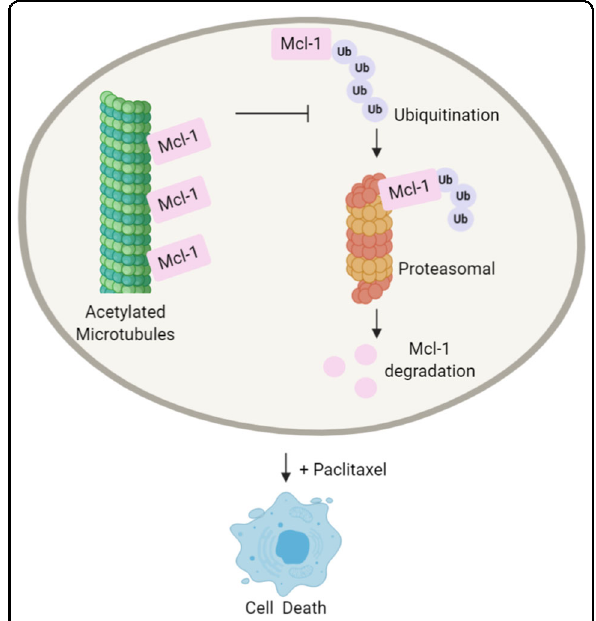
Fig. 7 Schematic presentation showing the regulation of tubulin acetylation on antiapoptotic Mcl-1 and paclitaxel resistance. Multiple administrations of paclitaxel induce upregulation of tubulin acetylation and Mcl-1 level. Mcl-1 preferentially interacts with this posttranslational modi fi cation (PTM) of microtubules, in which tubulin acetylation functions to stabilize Mcl-1 by protecting it from ubiquitin- mediating proteasomal degradation, and thereby conferring resistance to paclitaxel-mediated